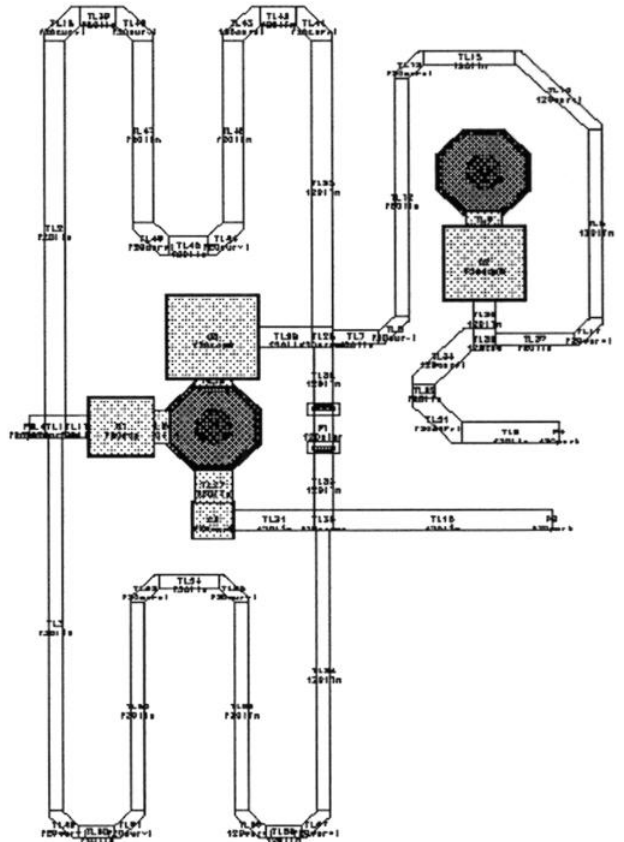
FIGURE 9 Final layout of the 90-deg coupler using a Wilkinson divider and a l = 4 long transmission